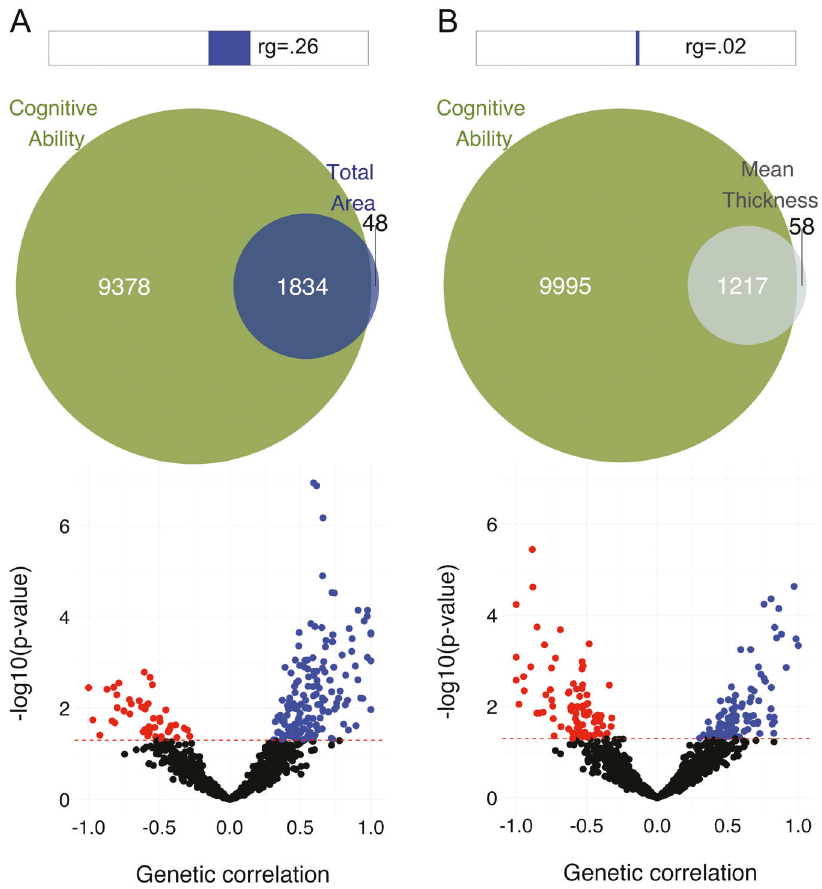
area ( A ) and mean thickness ( B ) [115]. The Venn diagrams below it re fl ect the amount of causal variants estimated to contribute to each of the traits as well as their overlap, regardless of effect directions, calculated through bivariate Gaussian mixture modelling [93]. At the bottom, volcano plots showing the results from Local Analysis of [co]Variant Annotation (LAVA) [94]. This explains the discrepancy between the two global metrics of overlap, as a mixture of opposing directions of local correlations will cancel each other out at the global